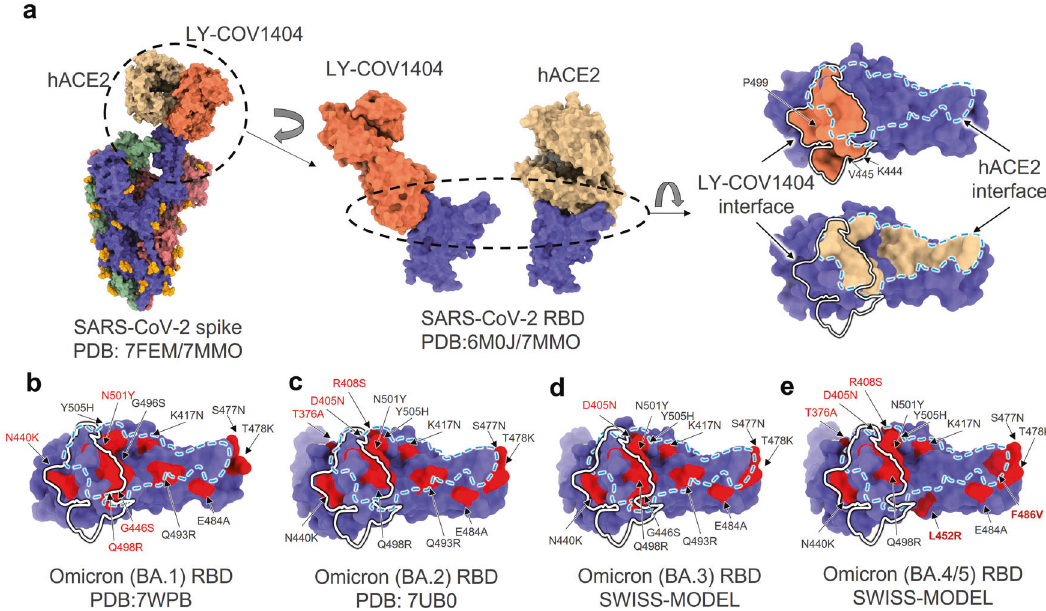
Fig. 2 Structural comparations of ACE2-RBD interface and bebtelovimab (LY-CoV1404)-RBD interface in S protein of Omicron sublineages. a Superposition of complex structures of SARS-CoV-2 spike with human ACE2 (hACE2) receptor (PDB entry 7FEM) and spike RBD domain with LY-CoV1404 neutralizing antibody (PDB entry 7MMO) are shown on the left panel. RBD-LY-CoV1404 interface (PDB entry 7MMO) and RBD- hACE2 interface (PDB entry 6M0J) are enlarged in the middle panel and plotted on the RBD surface in the right panel. SARS-CoV-2 S protein is colored in medium slate blue, light coral and dark sea green for three protomers, respectively. Spike RBD domain alone is colored in medium slate blue. The hACE2 and its interface are colored in burlywood. LY-CoV1404 and its interface are colored in coral. Interface edges of LY- CoV1404 and hACE2 on RBD surface are indicated by white dotted line or blue dotted line, respectively. b – e Structural comparison of LY- CoV1404 binding interface, hACE2 binding interface and point mutations on spike RBD surface in Omicron sublineages, including BA.1 (PDB entry 7WPB) ( b ), BA.2 (PDB entry 7UB0) ( c ), BA.3 (predicted by SWISS-MODEL) and ( d ), BA.4/BA.5 (predicted by SWISS-MODEL) ( e ). RBD surface, interface edges of LY-CoV1404 and hACE2 are shown as ( a ). Point mutations of Omicron sublineages are colored in red, dark red or fi rebrick, and labeled